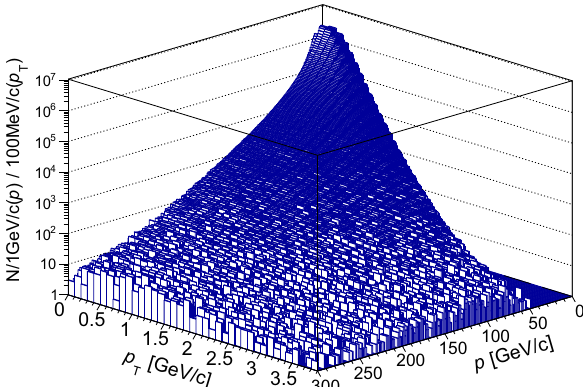
Figure 8 shows the muon p − p T distribution in data. Figure 9 gives a view of the differences between data and simulation in the p − p T plane. Plotted is the difference between number of data and simulated tracks divided by the sum of the tracks in data and simulation in bins of p and p T . For momenta above 150 GeV/c, the simulation under- estimates tracks with larger p T , while the total number of tracks predicted are in agreement within 20%. The difference between data and simulation is probably caused by a differ- ent amount of muons from pion and kaon decays. It was seen that by increasing the contribution of muons from pion and kaon decays in the simulation the difference between data and simulation was